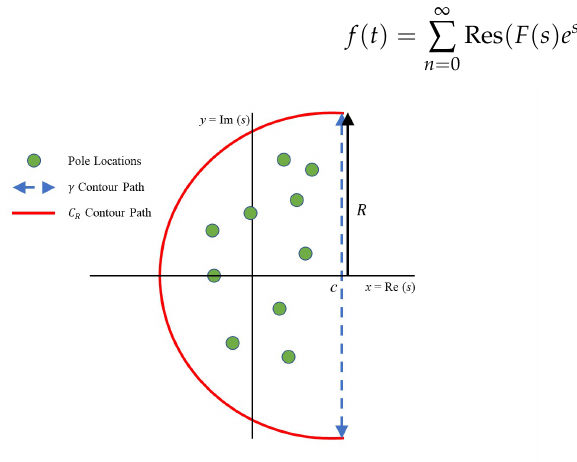
Figure 1. Bromwich contour (interested readers are referred to